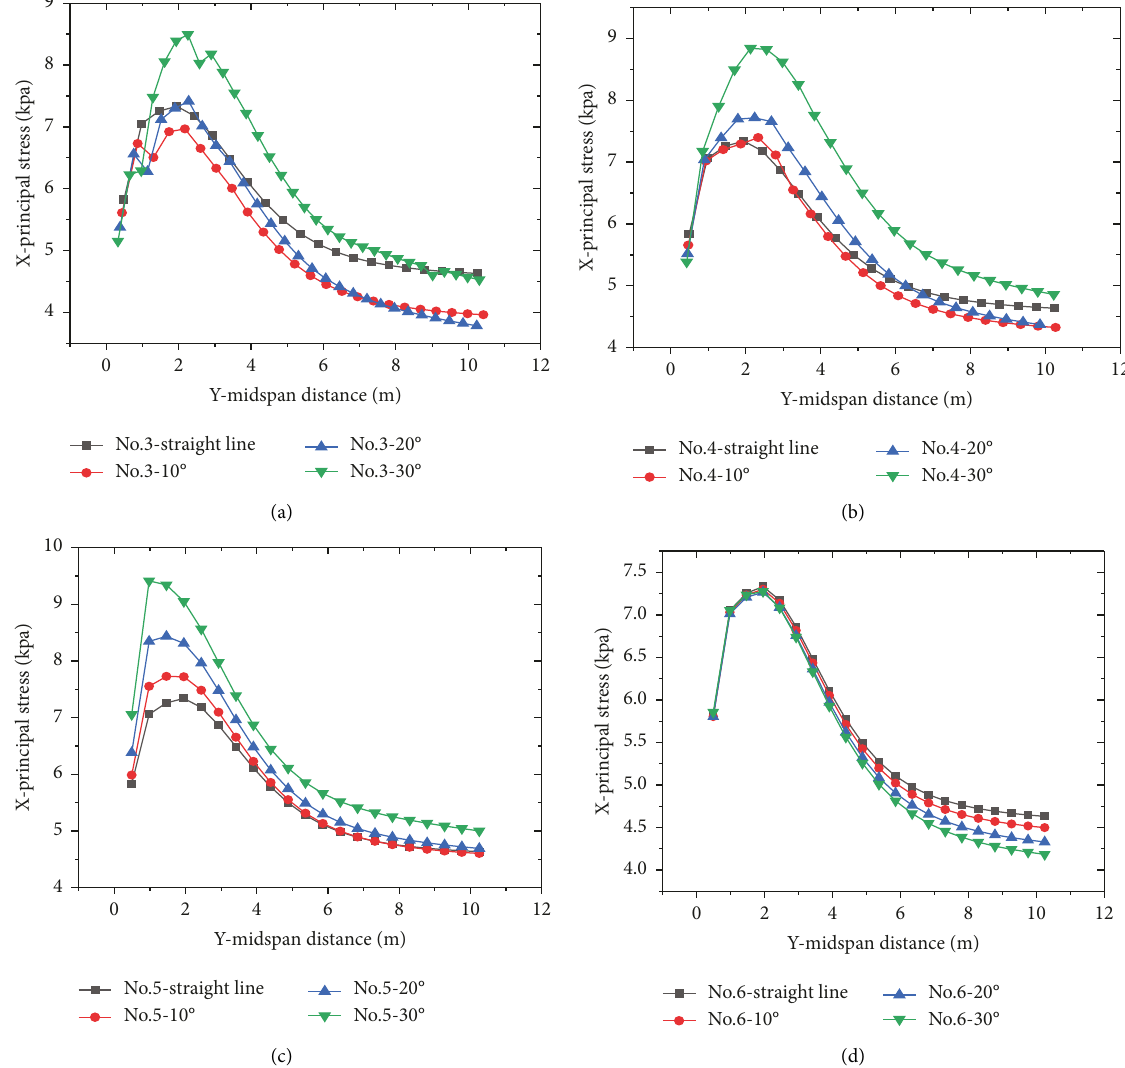
Figure 14: X-directional principal stress curves on the midspan symmetry planes of soil arches under polyline pile